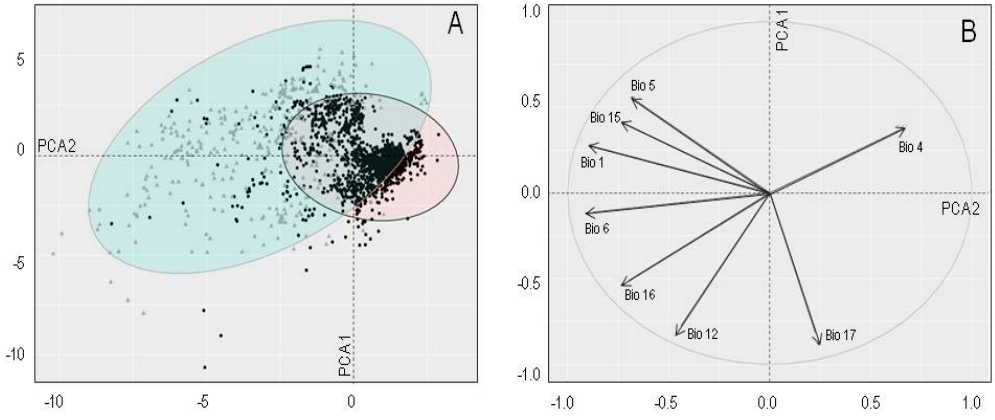
Figure 2. ( A ) The principal component analysis (PCA) for two Azolla filiculoides ranges. Grey triangles represent native localities and black dots represent invasive localities in the environmental space.